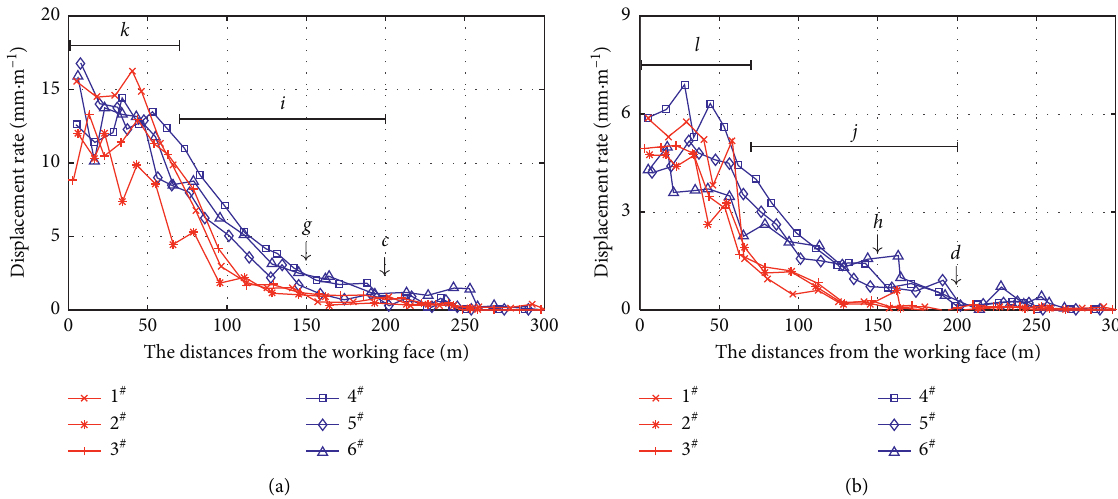
Figure 15: The surface deformation rate of the IRMR. (a) The displacement rate of the roof to floor. (b) The displacement rate of the tow